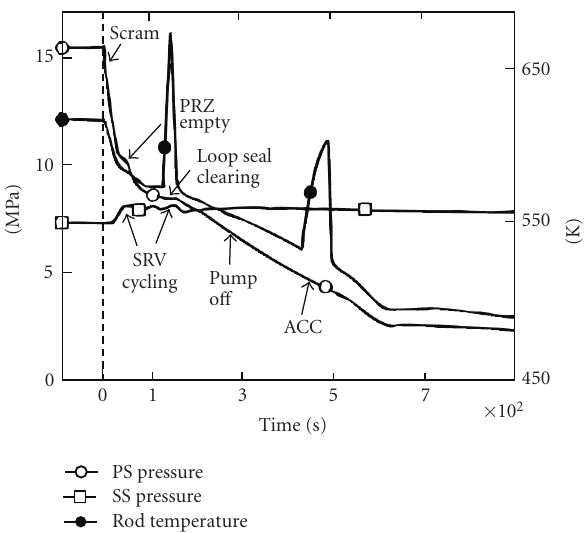
Figure 6: ISP-26 (ROSA-IV): experimental trends of primary and secondary side pressures and rod surface temperature.